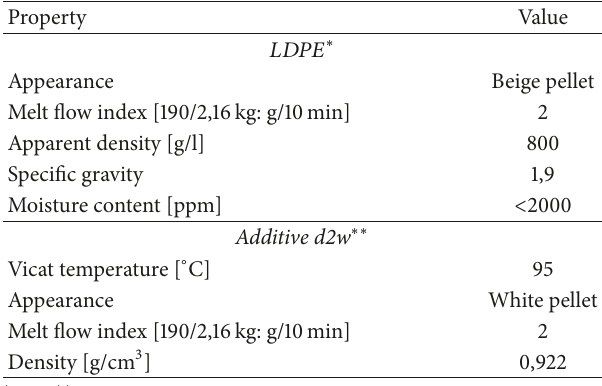
Table 1: Technical specification of neat LDPE and oxo-degradable